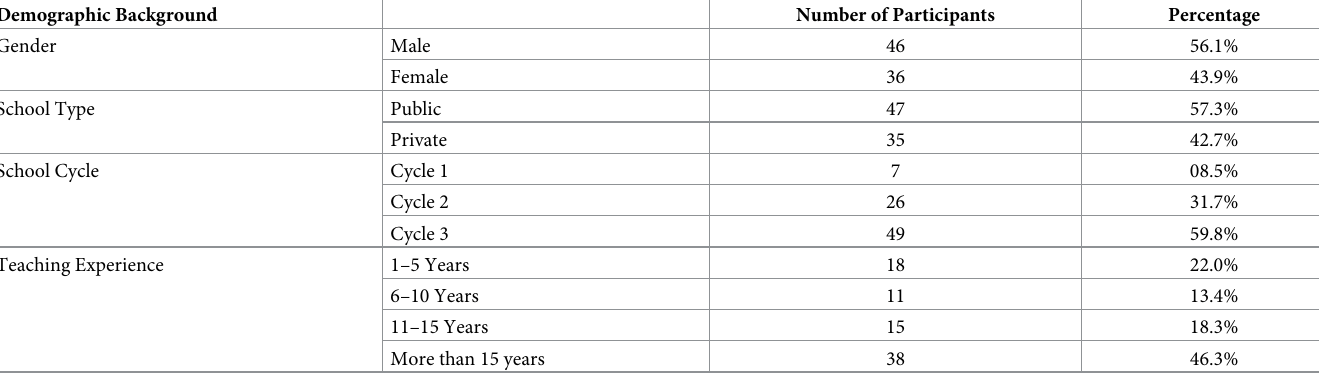
Table 1. Distribution of the teachers’ sample according to demographic characteristics (N =